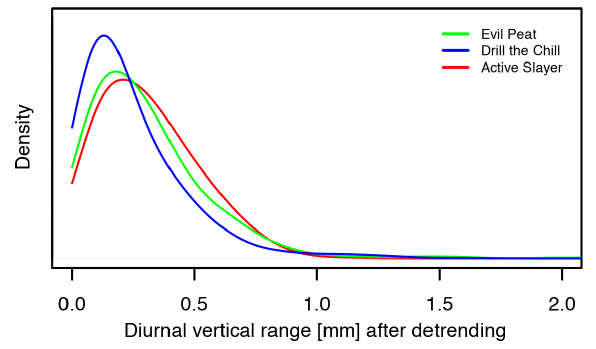
Figure 5. Probability density of diurnal vertical movement for all three sites. The height of the curves indicates the relative frequency of occurrence of intervals of diurnal vertical movement, for example those smaller versus larger than